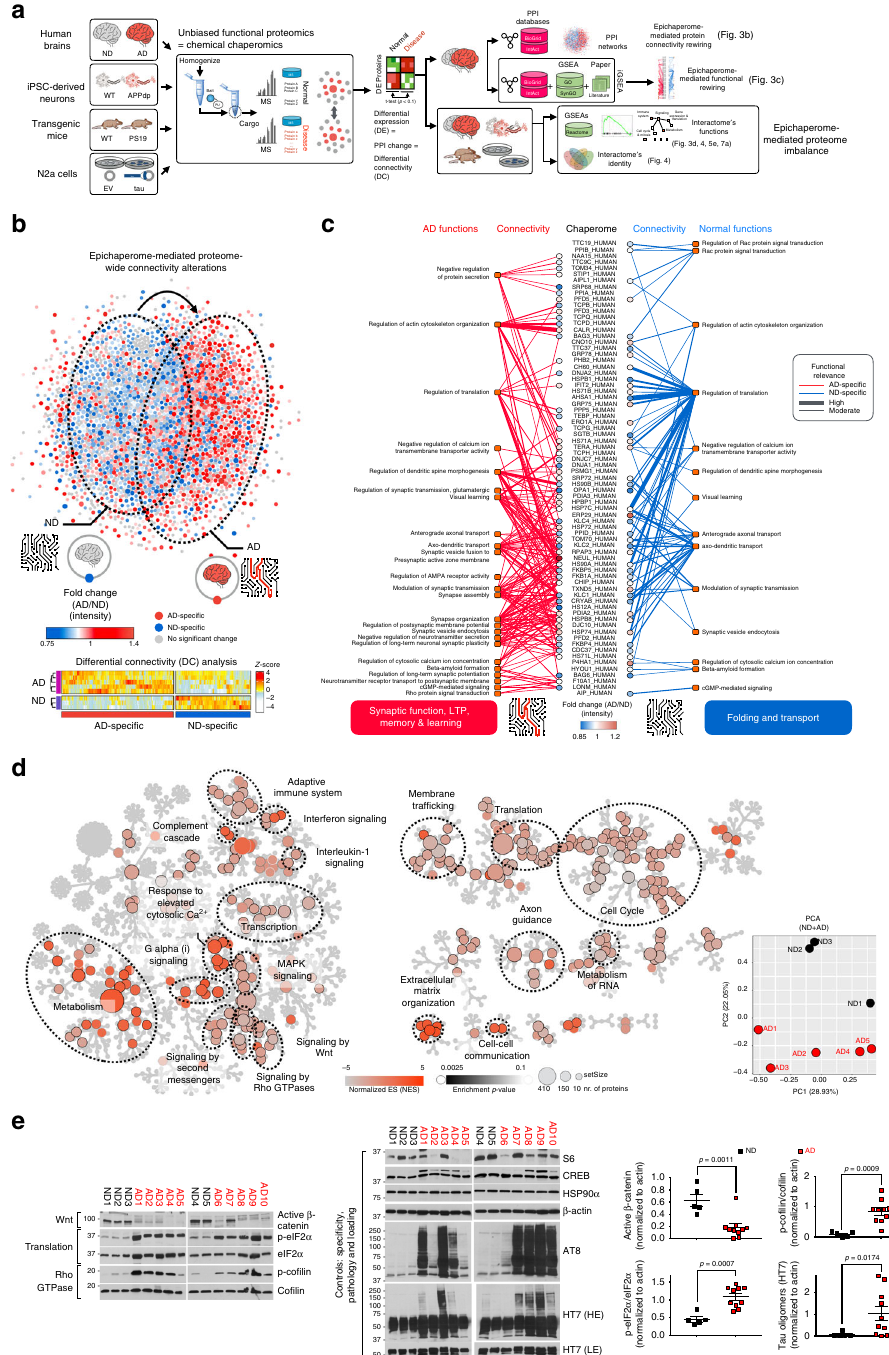
Fig. 3 The epichaperome mediates pathologic changes in proteome connectivity and function in AD. a Work fl ow used to identify epichaperome constituents and its interactome, and establish the identity and function of epichaperome-mediated protein – protein interaction (PPI) networks in AD. Individual AD ( n = 5) and ND ( n = 3) human brains were analysed in 2 – 4 replicates, and compared to indicated mouse and cellular models of AD. b PPI network map (top) and heatmap (bottom) showing epichaperome-mediated changes in the proteome and in protein connectivity. Each dot represents a protein (blue, ND-speci fi c, n = 942; red, AD-speci fi c, n = 1191). Edges (i.e., connections or PPIs) were removed for simplicity of presentation. Heatmap; differentially connected (DC) proteins, p < 0.1. DC = chaperome – proteome connectivity change. c Chaperome – proteome connectivity and its functional signi fi cance annotated over biological processes important for synapse biology. In the map ’ s center are chaperome members that participate in rewiring the connectivity of synaptic proteins between ND and AD; each blue and red line represents a PPI, and its functional outcome is presented at the end of each connection. d Functional analysis of the epichaperome and its interactome through Reactome pathway analyses uncovers protein pathways altered in AD through the epichaperome-mediated mechanism. Dysregulations in these pathways are shared among the sporadic AD brains. Principal component analysis (PCA) shows little relatedness among the individual AD interactomes. e Key effectors of select synaptic protein pathways from ( d ) were con fi rmed by western blot. HE, LE, high or low exposure, respectively. Graph, mean ± SEM, unpaired two-tailed t -test, with Welch ’ s correction for the tau oligomers, n = 5 for ND and n = 10 for AD. Source data are provided as a Source Data fi